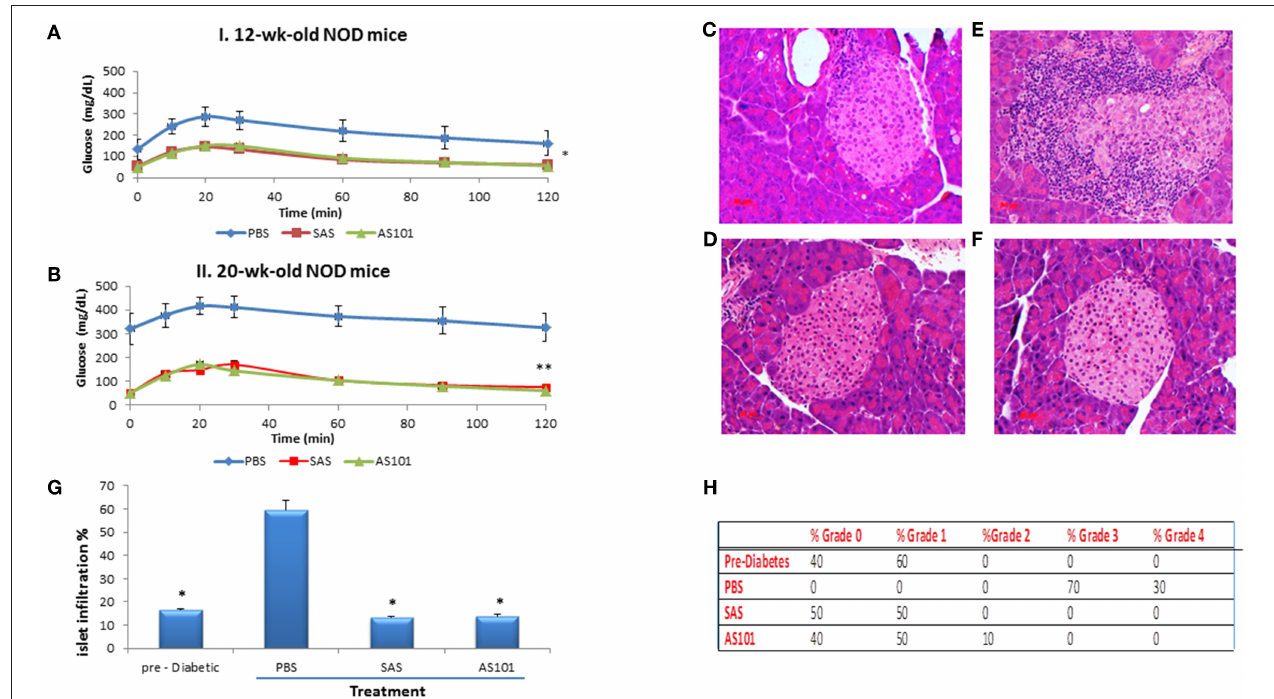
FIGURE 8 | Effect of the compounds on islet morphology and insulitis. AS101 or SAS at 1mg/kg/injection were administered i.p. every other day to female NOD mice, starting at 3 weeks of age. At 12 weeks (A) (beginning of insulitis) or at 20 weeks (B) (severe diabetes)., mice were starved O.N. and injected i.p. with 2gr/kg glucose. Blood glucose levels were monitored at different time points. ** p < 0.01 vs. PBS; * p < 0.05 vs. PBS. N = 10/group. (C–F) At 20 weeks, pancreatic heads were fixed and stained with H&E. (C) Pre-diabetic mice islets at 5w. (D) PBS. (E) AS101 (1 mg/kg/injection). (F) SAS (1 mg/kg/injection). Results show representative data of five mice/group. X200. (G) Percent insulitis of 5 mice/group at 20 weeks in comparison to islets from 5 weeks old mice (pre-diabetic). 20 islets/mouse were scored. * p < 0.01 vs. PBS. (H) Percentage of infiltrating cells according to the severity of insulitis. Grade 0, No insulitis (no infiltration); Grade 1, Pre-insulitis ( < 25% of the islet